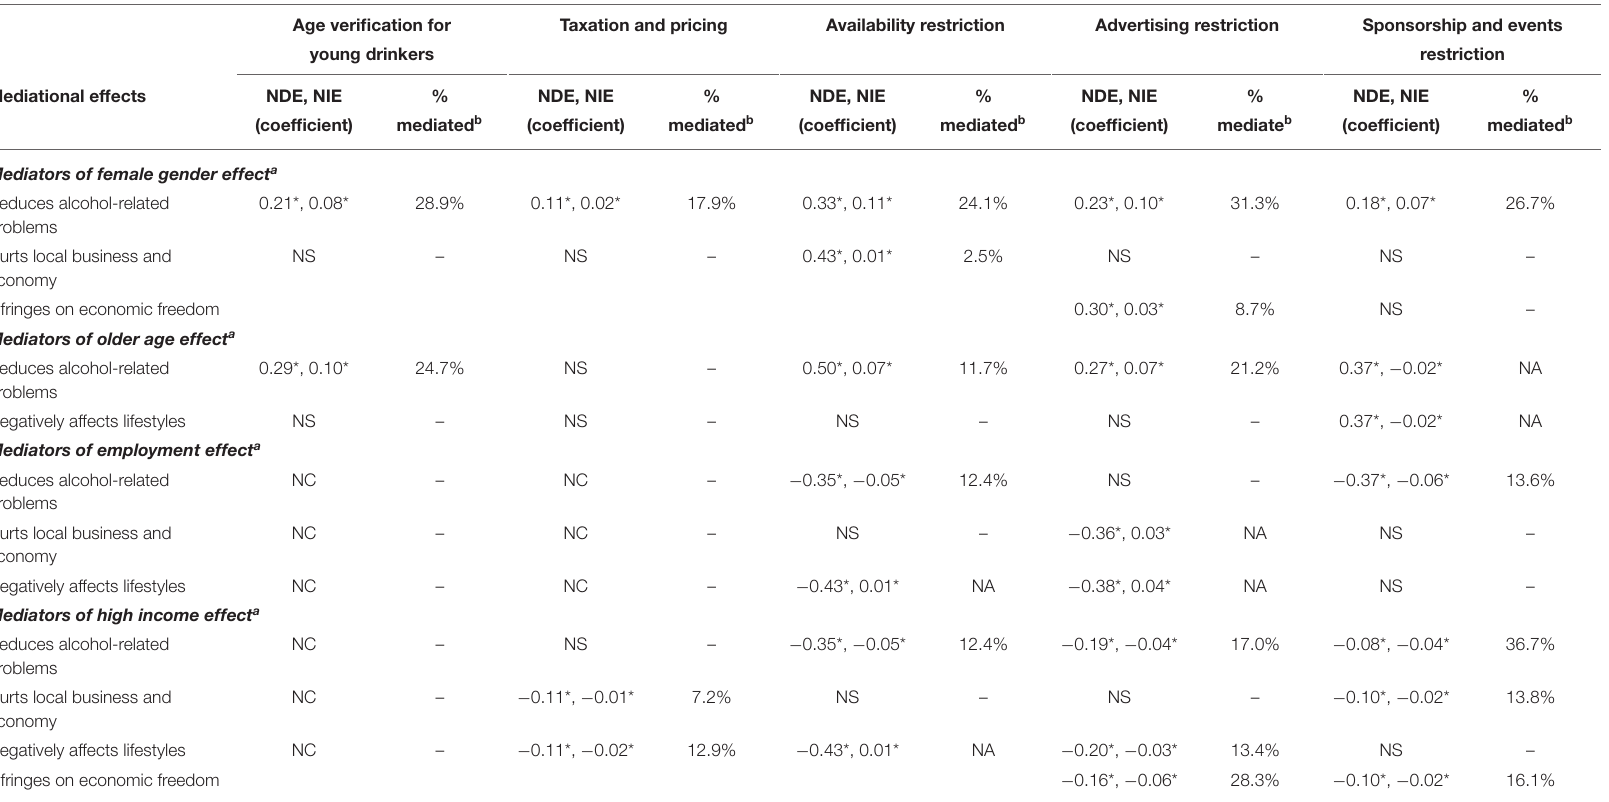
TABLE 6 | Mediational effects of perceived consequences in associations between socio-demographic factors and support for alcohol harms reduction strategies measured by PC scores, adjusted for other socio-demographic